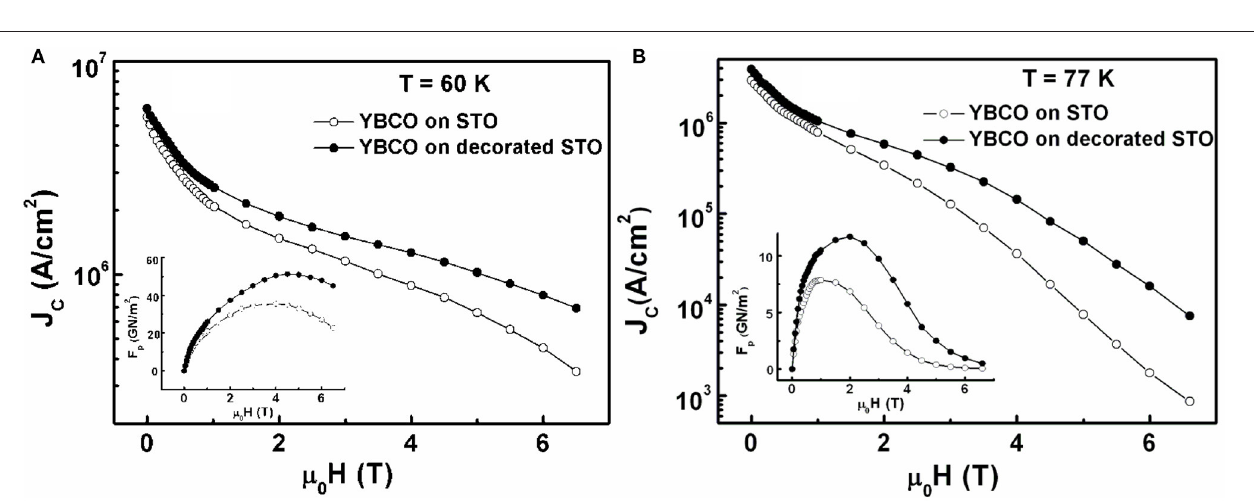
FIGURE 17 | Atomic force micrograph of STO substrates (A) without decoration and (B) decorated with LSMO nanoparticles. The random distribution of LSMO nanoparticles on the STO substrate surface can be clearly observed in Figure (B) . Reproduced from Jha et al. [165], with the permission from AIP Publishing.